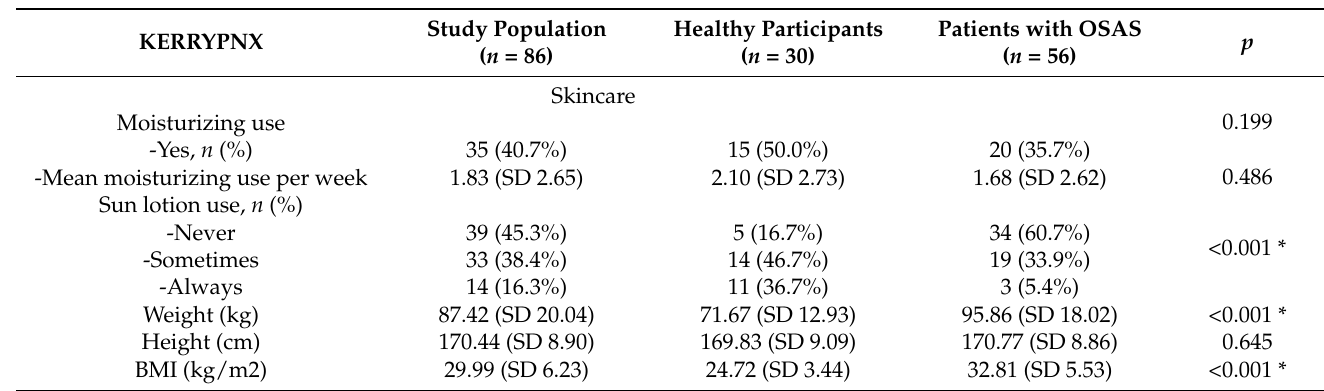
Table 3. Differences in skin barrier function in patients with OSAS depending on disease severity.